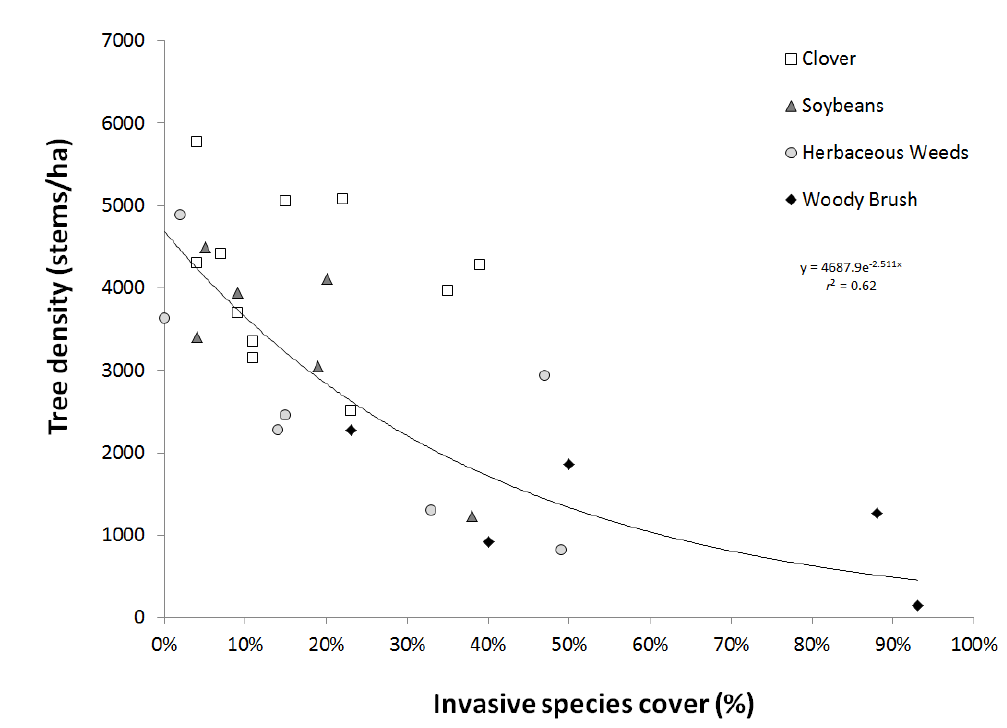
Figure 4. Relationship between native species tree density and invasive species cover ( r 2 = 0.62). Land Cover Types (LCT) are distinguished by unique symbols for each LCT.